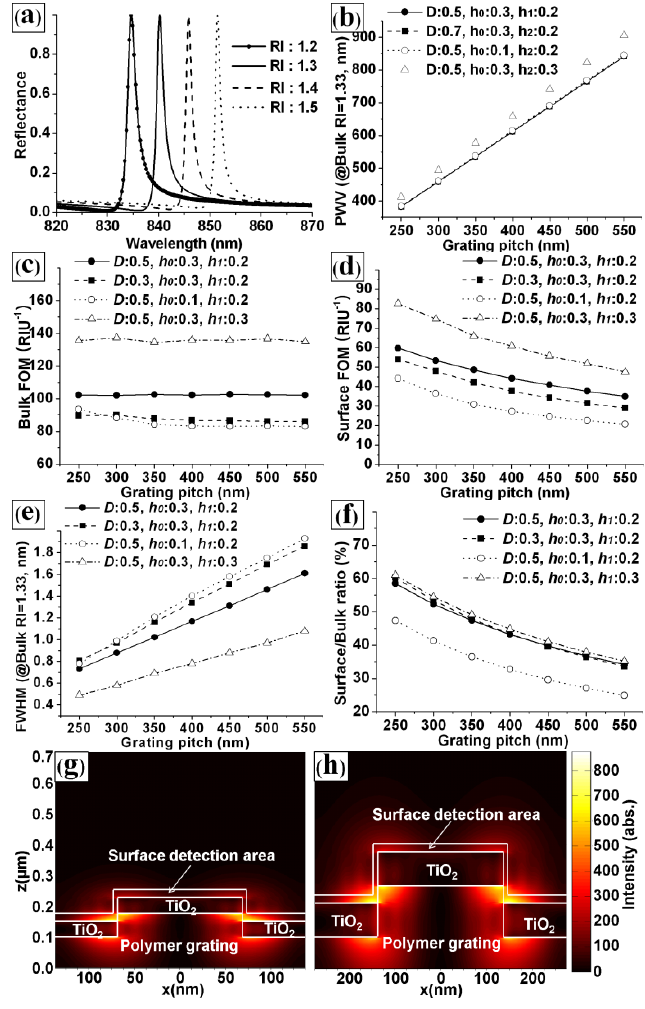
Figure 3. ( a ) Simulated reflection spectra of the PC structure for various sample